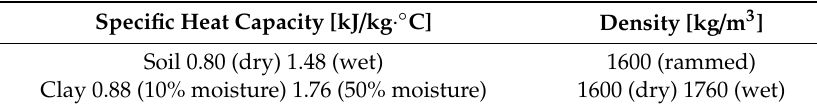
Table 4. Some physical properties of the soil.